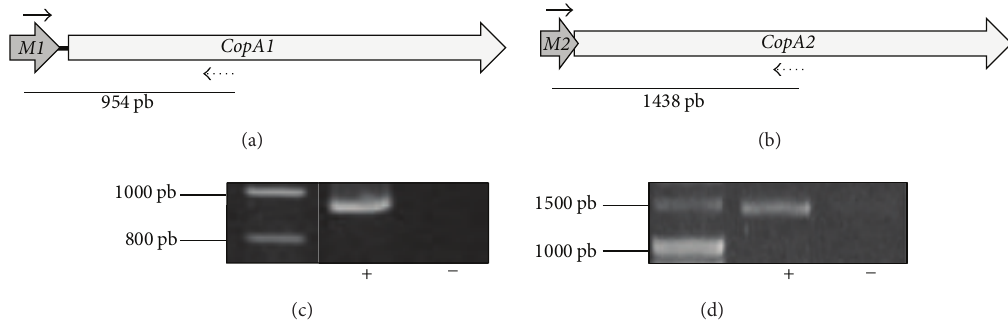
Figure 7: Cotranscription analysis of copMA1 and copMA2 genes. cDNA was synthesized with a reverse primer (dotted arrows) hybridizing toward the 3 󸀠 end of either copA1 (a) or copA2 (b). S. metallicus total RNA was extracted at the late exponential phase from a culture growing in presence of 20mM Cu. PCR amplifications were carried out with these cDNAs and each corresponding primer pair (black arrows) as listed in Table 1. (c) and (d) show RT-PCR products obtained for the copMA1 and copMA2 intergenic regions, respectively. Reverse transcriptase reactions with (+) and without (−) the Improm II reverse transcriptase enzyme were carried out in order to exclude amplification due to genomic DNA contamination. Expected sizes (in base pairs) for the corresponding PCR products are given in (a) and (b).